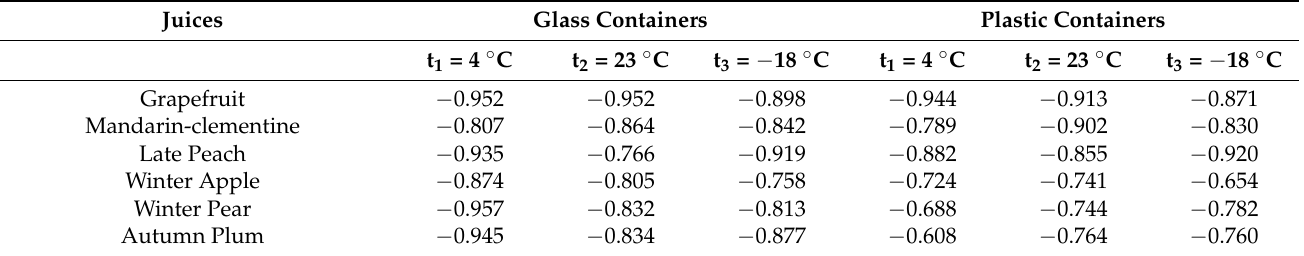
Table 2. The correlation coefficients between the amount of vitamin C (mg/100 g) present in fruit juices kept in glass and plastic containers at various temperatures and for varying lengths of